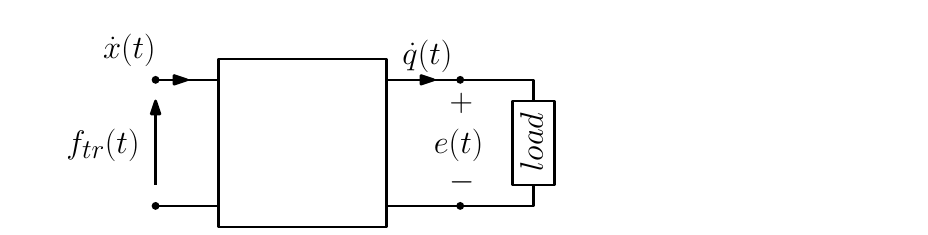
Figure 3. Piezoelectric transducer as an electromechanical two-port closed on an electrical load. At the left port are mechanical quantities: velocity ˙ x and force f tr ( t ) . At the right port are electrical quantities: current ˙ q and voltage e ( t )